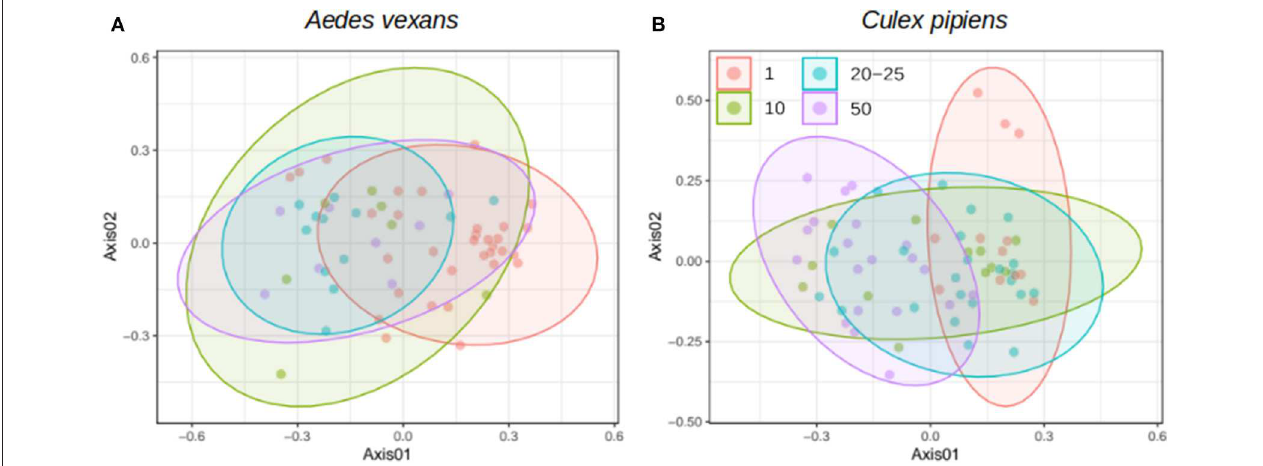
FIGURE 3 | NMDS showing the beta-diversity of (A) Aedes vexans and (B) Culex pipiens microbiomes according to the number of mosquitoes pooled per sample. Confidence ellipses are shown for each group.